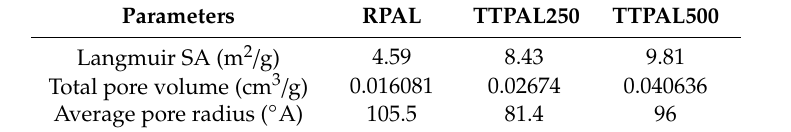
Table 6. Brunauer − Emmett − Teller (BET) analysis of RAPL and thermally treated samples. Table 6. Brunauer–Emmett–Teller (BET) analysis of RAPL and thermally treated samples.